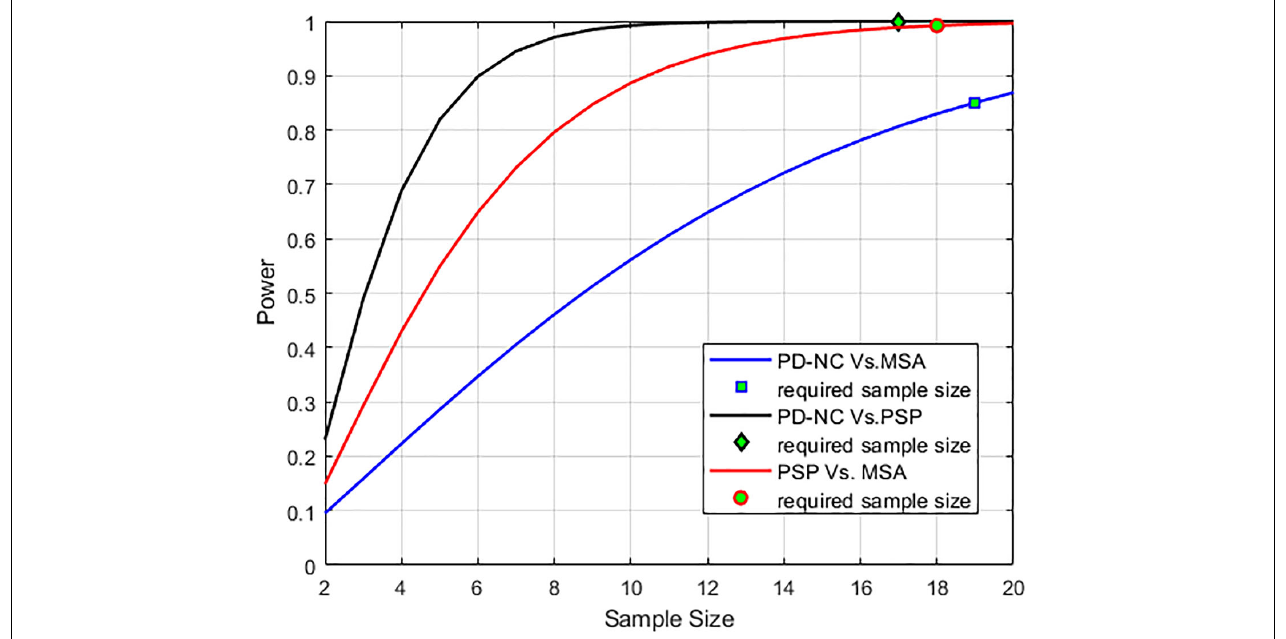
FIGURE 6 | Power analysis curve is plotted that showed high statistical power of the analysis. The minimum number of sample size that is required ( n = 17 to classify PD-NC vs. PSP, n = 18 to classify PSP vs. MSA and n = 19 to classify PD-NC vs. MSA) to obtain the desired power is also shown.